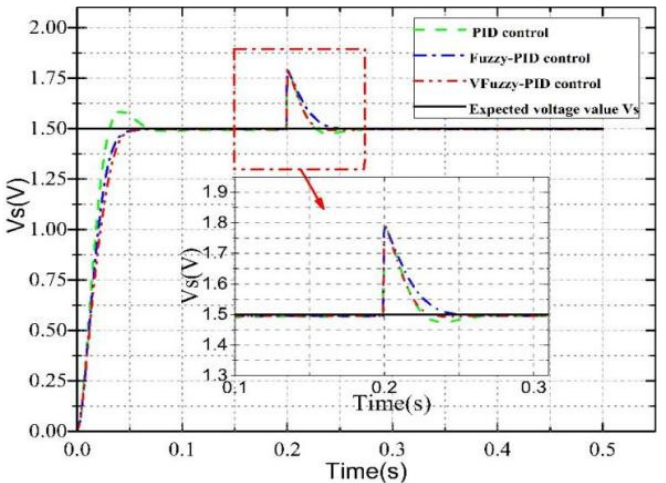
Figure 10. Simulation curve of inter-electrode voltage control of the magnetic actuator for micro-EDM.